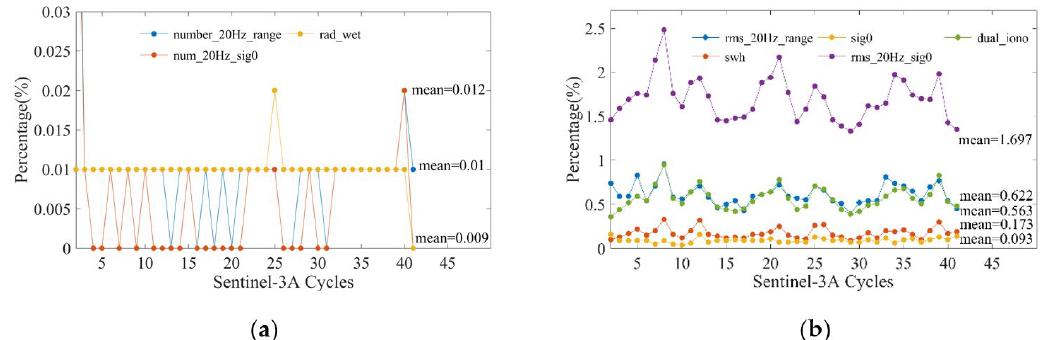
Figure 2. Cycle by cycle percentages of rejected measurement by Sentinel-3A SRAL by the thresholds of ( a ) number of 20 Hz range measurements, number of 20 Hz Sigma0 measurements and radiometer wet tropospheric correction, and ( b ) RMS of 20 Hz range measurements, RMS of 20 Hz Sigma0 measurements, dual frequency ionospheric correction, Sigma0 and SWH during cycle 3–41.